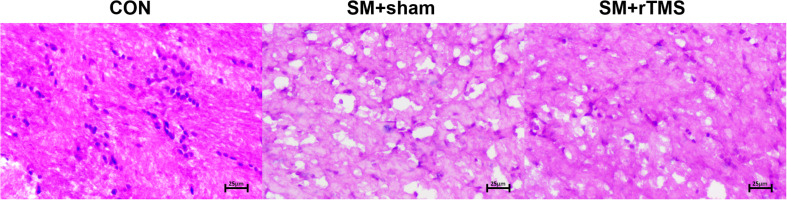
Schematic results of HE staining of motor cortex. Morphological changes of nerve cells in motor cortex. The sections of tissue were HE stained. In the schematic diagram, the shape difference and rupture degree of different cells in different groups can be observed. Pictures were all at 20× magnification.